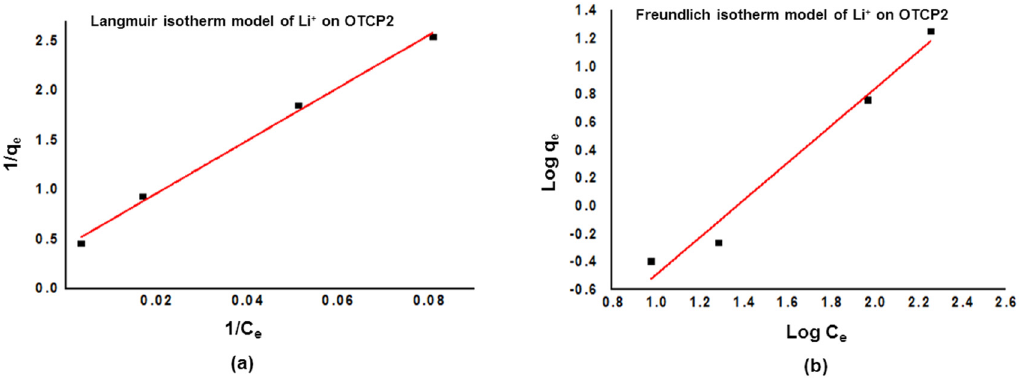
Figure 5. Langmuir isotherm ( a ) and Freundlich isotherm ( b ) models of Li + on OTCP2. Table 2. Langmuir and Freundlich isotherm model parameters for Li + adsorption on OTCP2. Ion